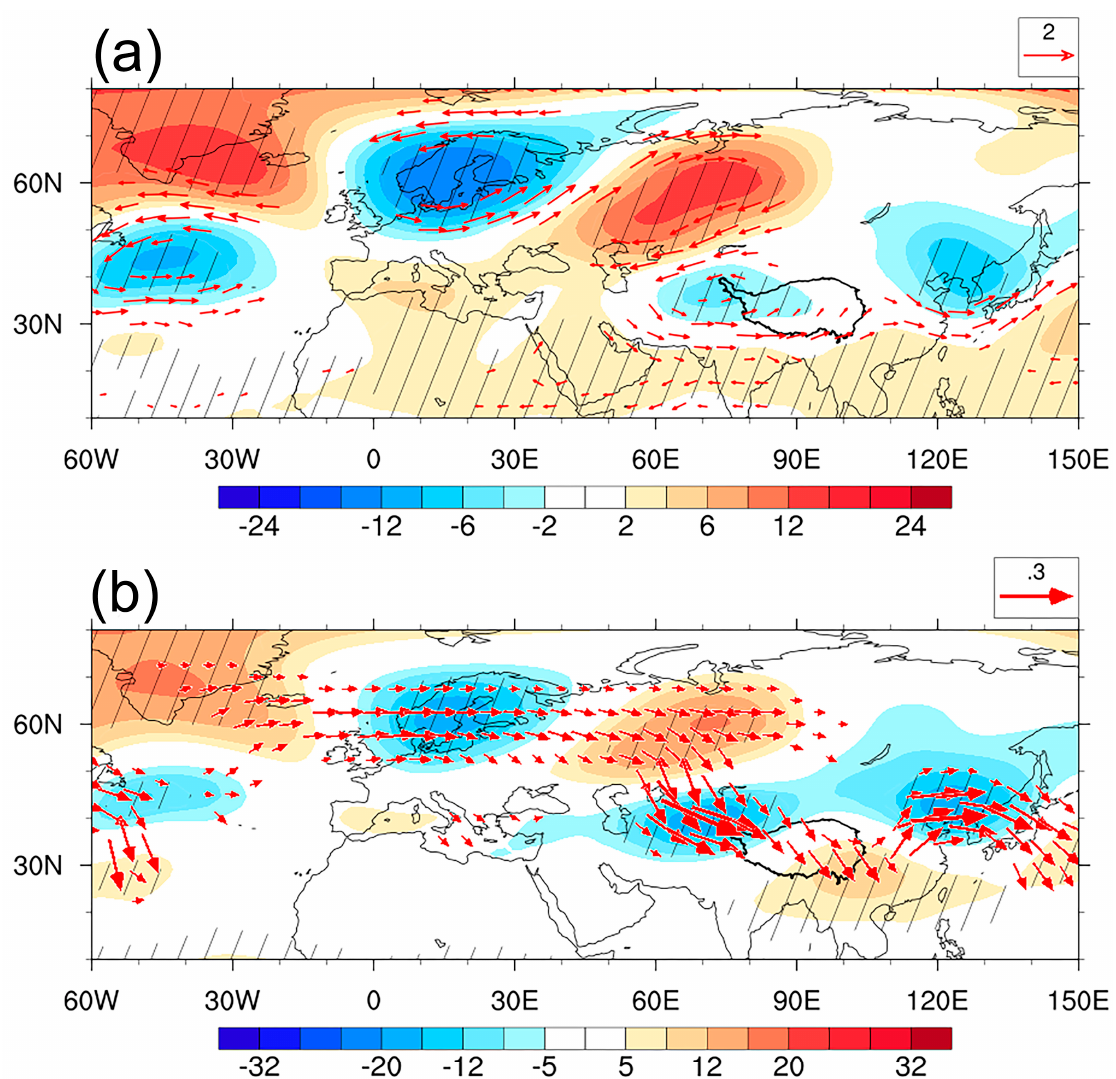
Figure 10. Anomalies in the interannual component of 500 hPa geopotential height (shading, gpm) and wind passing the 95% confidence level (vector, m/s) ( a ), the 200 hPa geopotential height (shading, gpm), and the wave activity flux (vector, m 2 s − 2 ) ( b ) regressed on PC2-IA. Grid points with statistically significant anomalies passing the 95% confidence level are denoted by oblique lines.